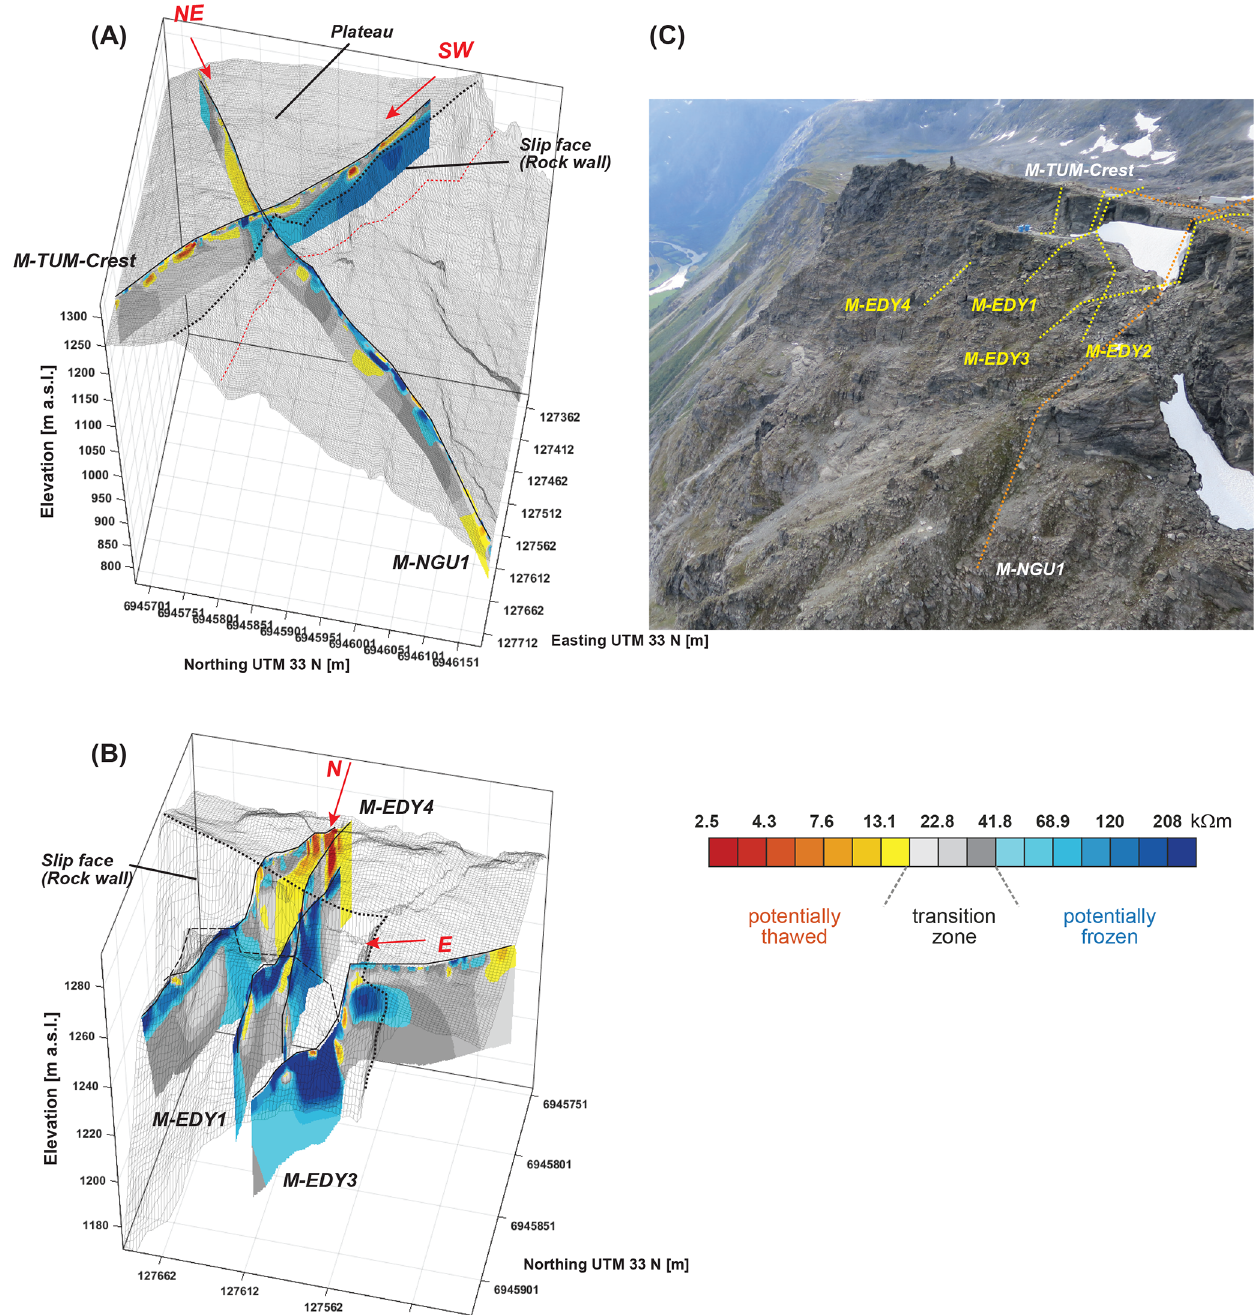
Figure B2. 3D plots showing the ERT profiles in relation to topography for the Mannen instability. The arrows indicate topographic orienta- tion of the profiles. The black stippled line indicates the crest forming the transition between plateau and rock walls. (a) M-TUM-Scarp and M-NGU. Plateau and rock wall are indicated in the plot. (b) Rock wall ERT profiles M-EDY1 to 4. They deviate from straight lines because of high topography and safety constraints. (c) Oblique air photo (© Pierre-Allain Duvillard), with approximate location of the ERT profile